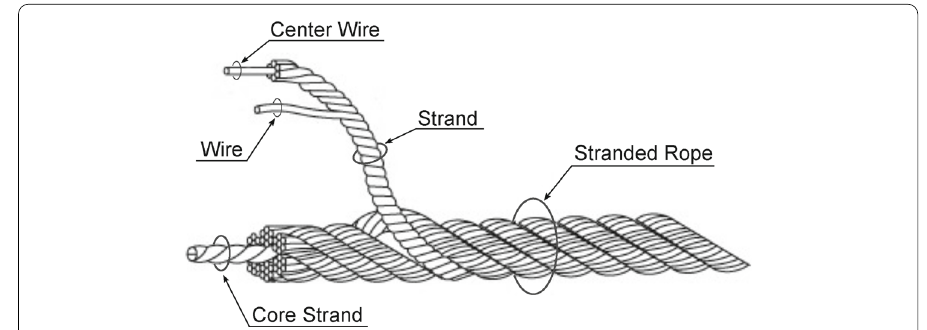
Fig. 1 Stranded rope and its constituents, adapted from [22]. This work focuses on the core strand